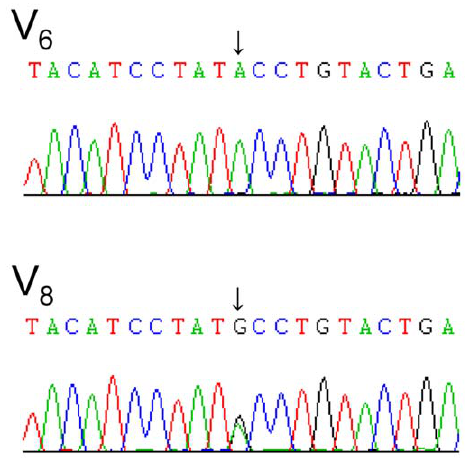
Figure 3. Sequencing raw data of subjects V 6 (an unaffected member) and V 8 (an affected member). The data are from the reverse complementary sequencing with the primer DSPP_New3R. The arrows show the complementary nucleotide of g.8662 site. V 6 has homozygous A while V 8 has heterozygous A/G.